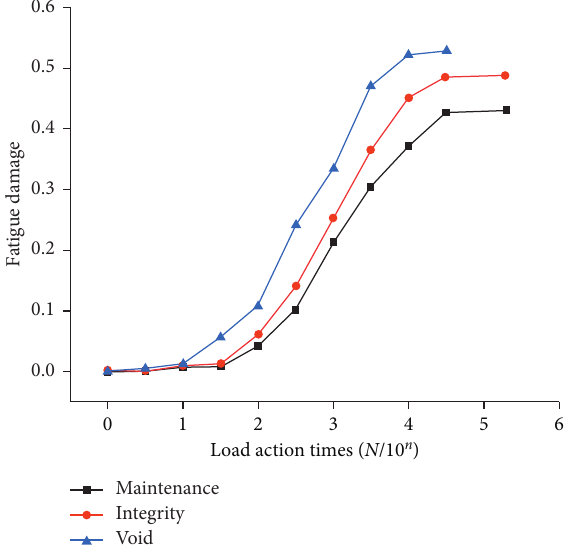
Figure 24: Cumulative evolution of fatigue damage under three basic working